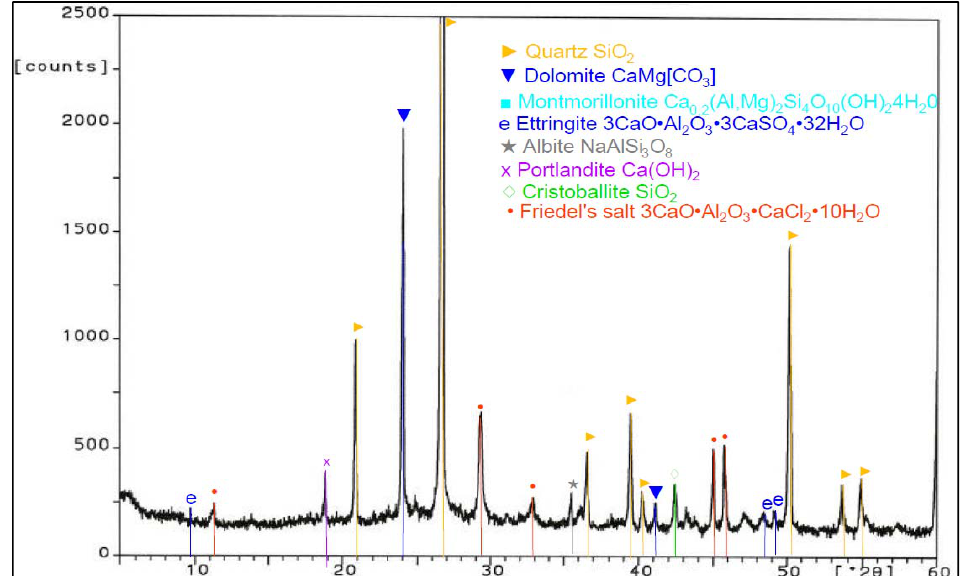
Figure 26. XRD pattern of the ZIII mortar (CEM I + 45% FBC) stored in 1% HCl for 730 days.